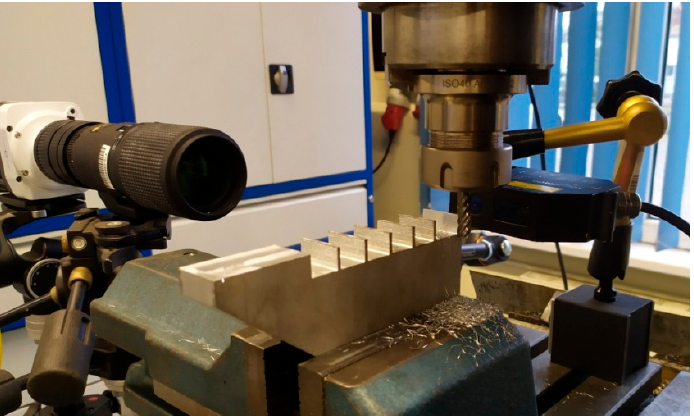
Figure 3. Photo of test stand.